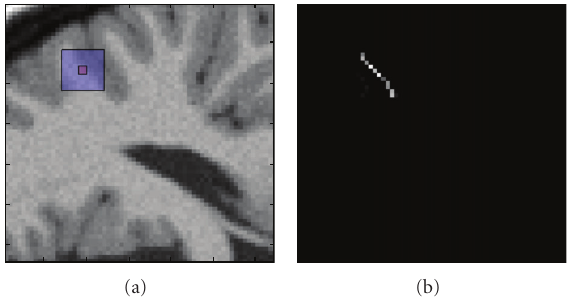
Figure 1: (a) Each filtered pixel in the image (e.g., center pixel of the red square) is computed as the weighted average of all the pixels of the search window (blue square). (b) Weights of pixels of the search region as calculated by (2). As can be observed in the example edge pixels are averaged with other edge pixels preventing the blurring e ff